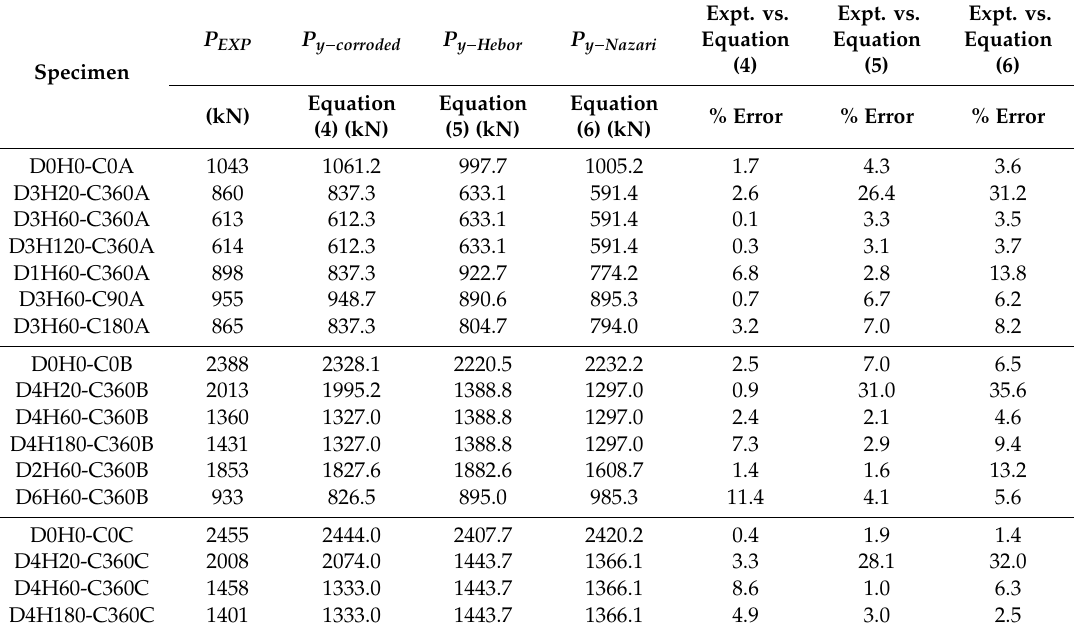
Table 5. Calculated residual compressive yield